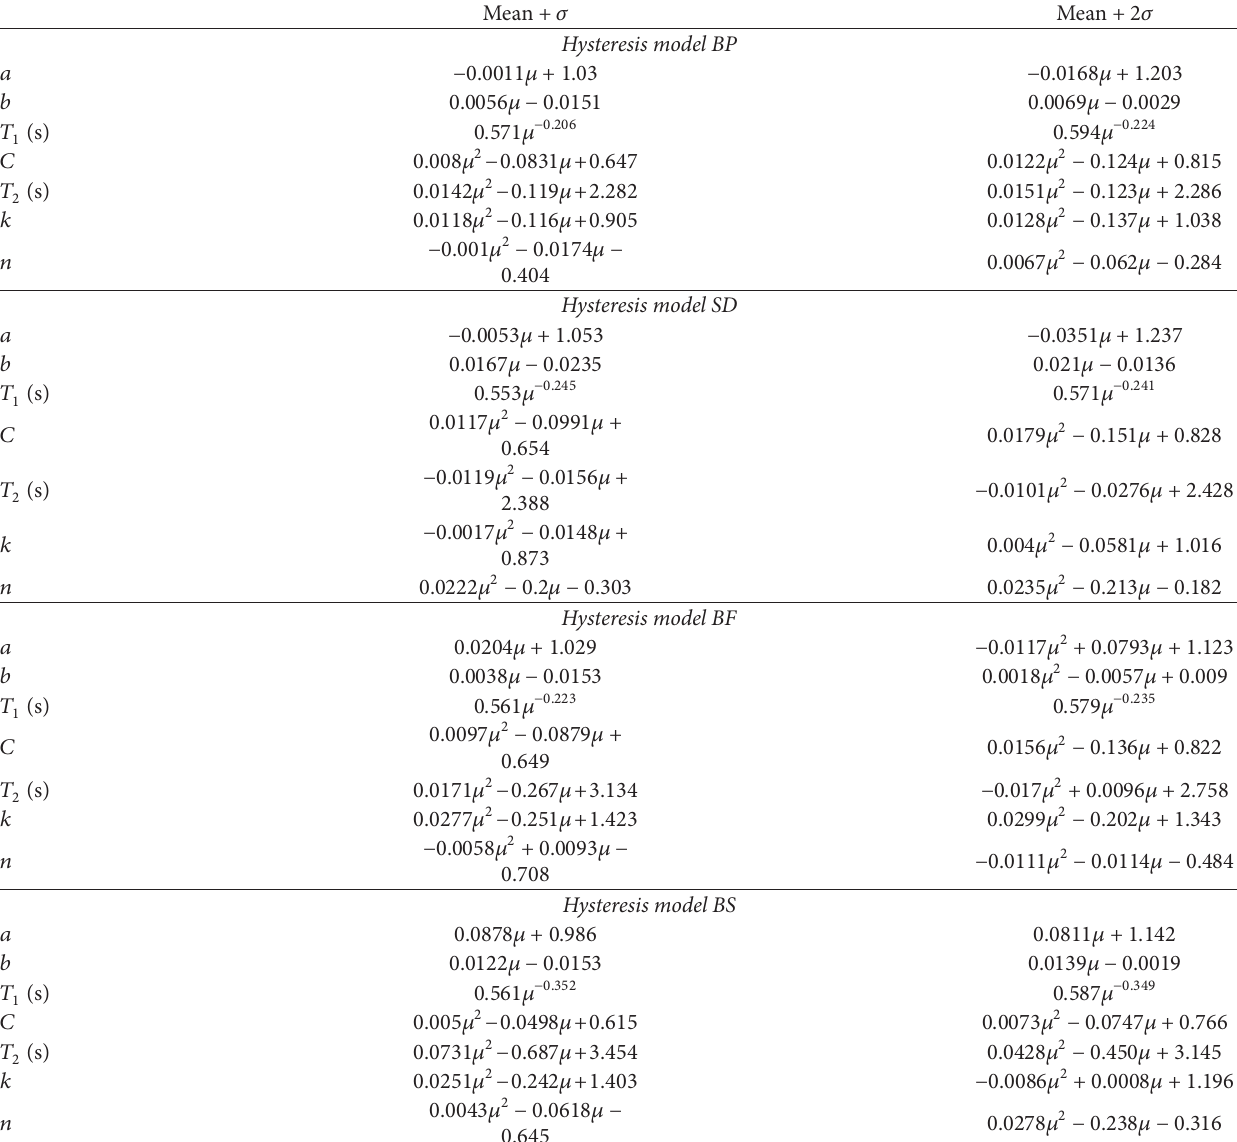
Table 8: Normalized input energy spectral shape parameters (site class